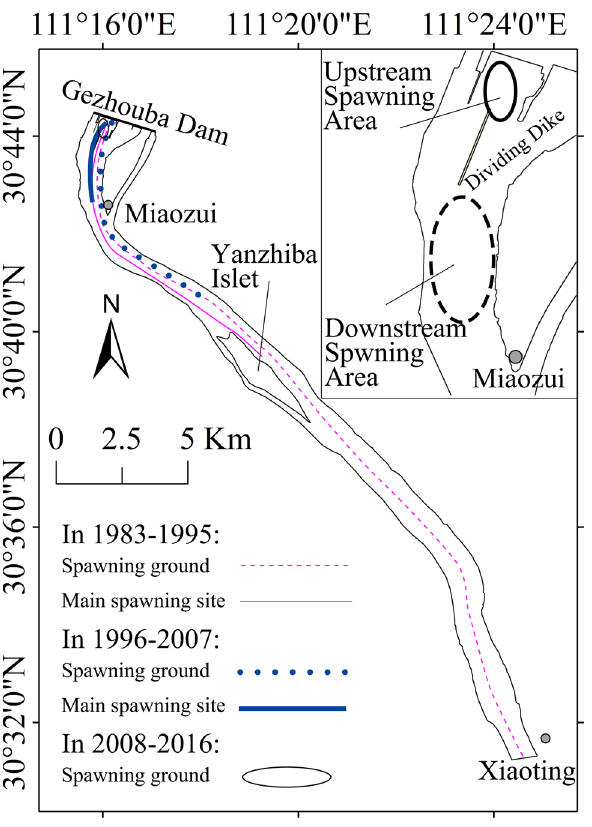
Figure 8. Changes in the spawning ground downstream of Gezhouba Dam of the Chinese sturgeon. Map generated in ArcGIS Pro (https:// www. esri. com/ en- us/ arcgis/ produ cts/ arcgis- pro/ overv